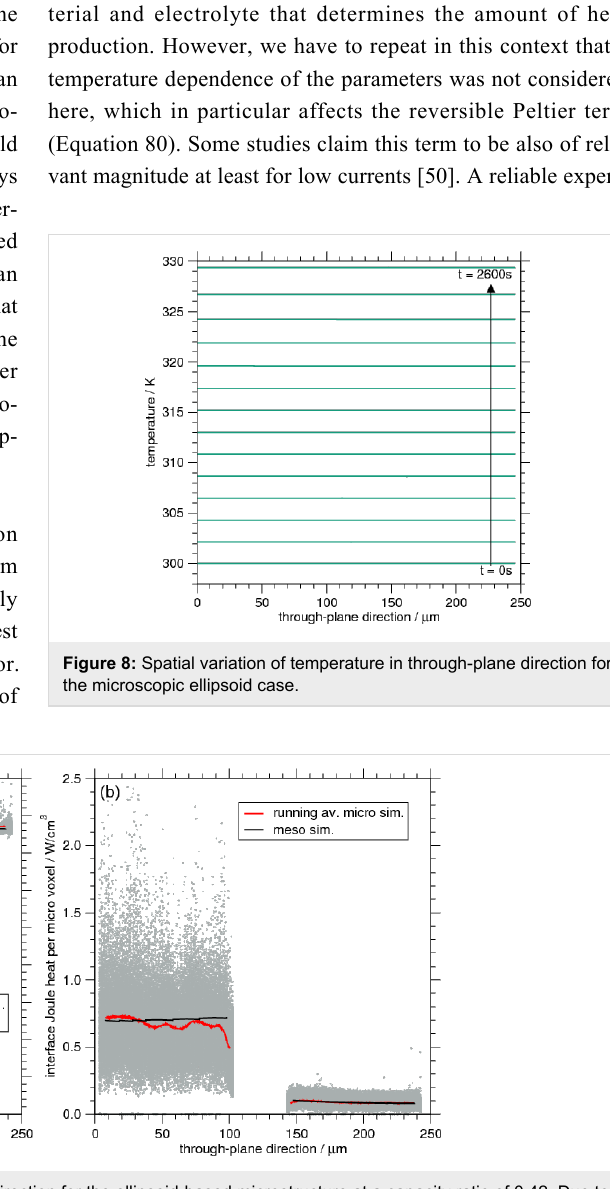
Figure 7: (a) Spatial distribution of the overpotential in through-plane direction for the ellipsoid-based microstructure at a capacity ratio of 0.42. Due to the strong variation of the data in the microscopic simulations (grey), a running average (red) is compared to the overpotentials of the mesoscopic simulations (black). (b) Similar as in (a) we compare the Joule heat at the interface between active particles and electrolyte.